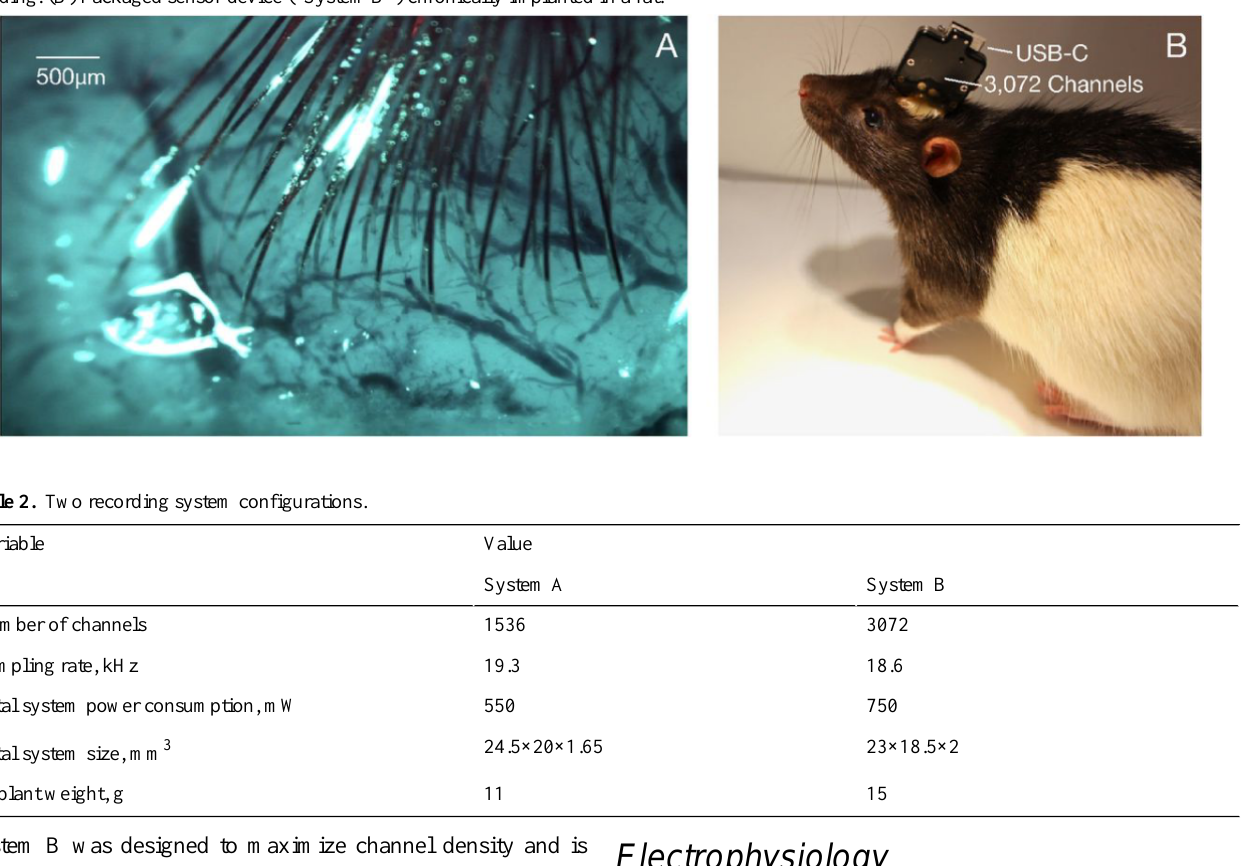
Figure 6. Thread implantation and packaging. (A) An example perioperative image showing the cortical surface with implanted threads and minimal bleeding. (B) Packaged sensor device (“System B”) chronically implanted in a rat.